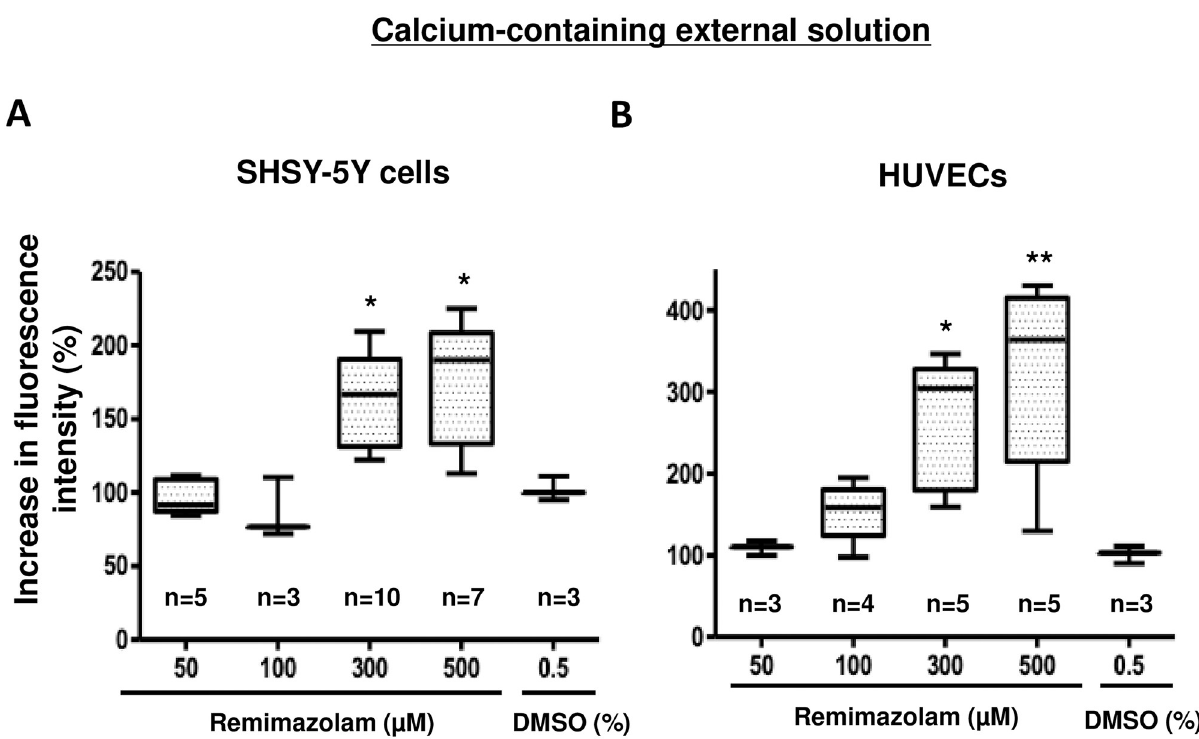
Fig 2. Remimazolam-induced intracellular calcium elevation in SHSY-5Y cells and HUVECs. (A) Remimazolam at a concentration greater than or equal to 300 μ M significantly induced the elevation of intracellular calcium in a dose-dependent manner in SHSY-5Y cells (n = 3–7, � p < 0.05, compared to control, one-way ANOVA followed by Dunnett’s post-test). The horizontal line in each box indicates the median, the box shows the interquartile range (IQR), and the whiskers represent 1.5 × IQR. (B) Remimazolam at a concentration greater than or equal to 300 μ M significantly induced the elevation of intracellular calcium in a dose-dependent manner in HUVECs (n = 3–5, � p < 0.05, �� p < 0.01, compared to control, one-way ANOVA followed by Dunnett’s post-test). The horizontal line in each box indicates the median, the box shows the interquartile range (IQR), and the whiskers represent 1.5 ×